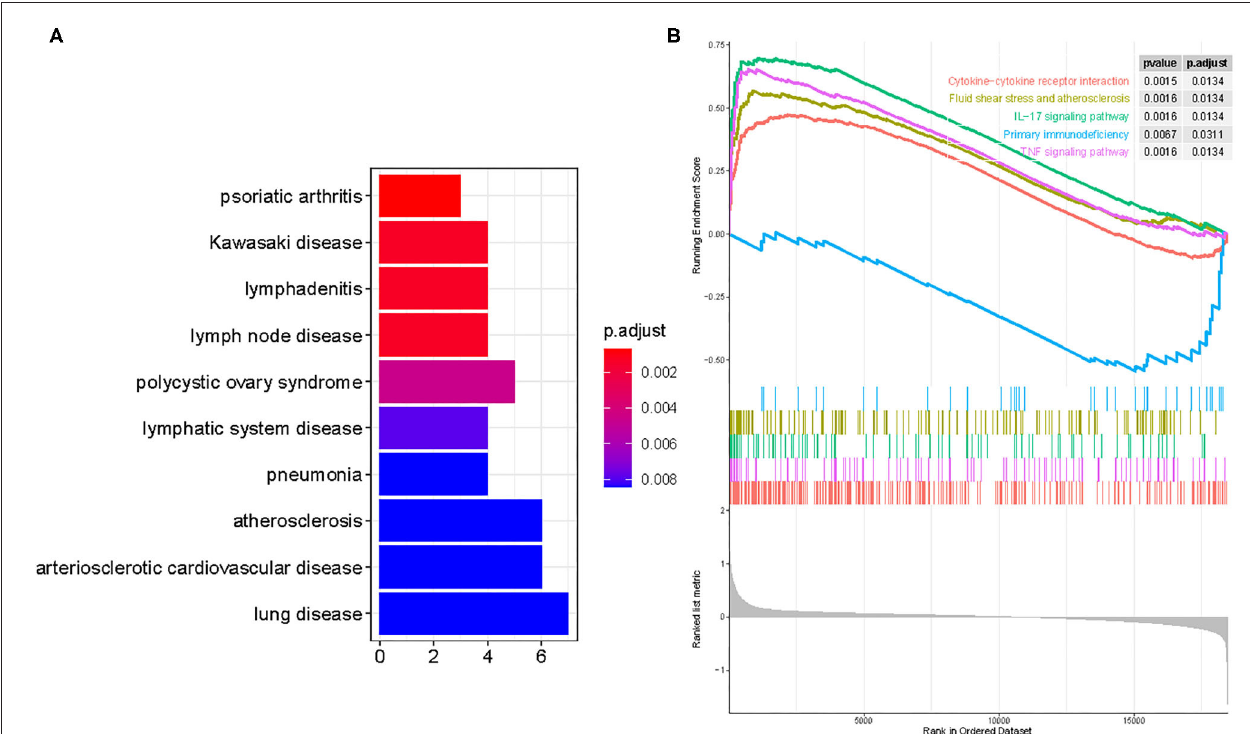
FIGURE 2 | Functional enrichment analyses to identify potential biological processes via disease ontology and gene set enrichment analysis. (A) Disease ontology enrichment analysis of differentially expressed genes between AMI and control samples. (B) Enrichment analyses via gene set enrichment analysis.